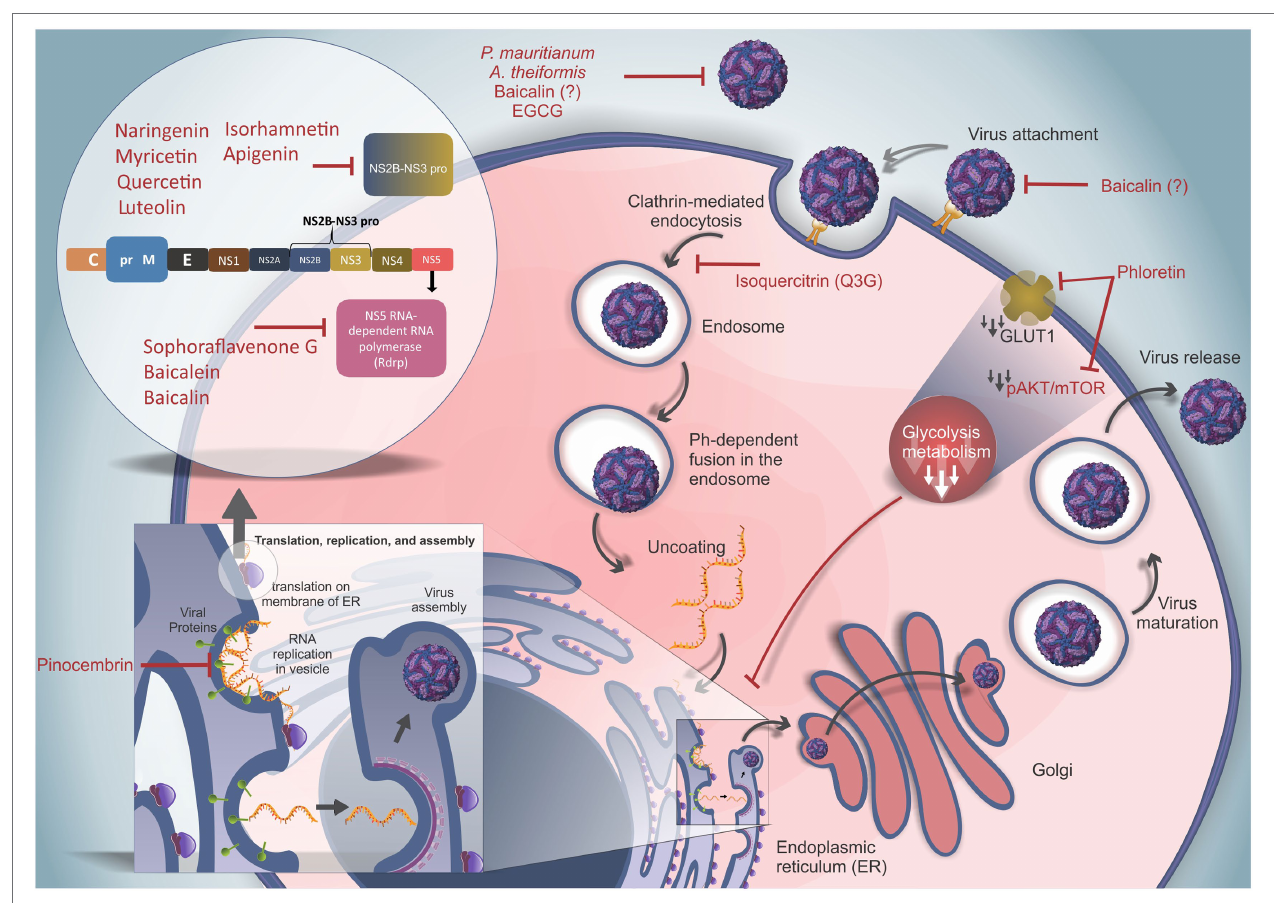
FIGURE 3 | Replication cycle of ZIKV and the actions of different flavonoids. Free viral particles can be disrupted by the actions of curcumin, Psiloxylon mauritianum extract, Aphloia theiformis extract, baicalin, and epigallocatechin gallate (EGCG) before binding of the virus to cell receptors. ZIKV attaches to host receptors and is internalized by clathrin-mediated endocytosis. This phase can be inhibited by curcumin and baicalin, but the inhibitory mechanism needs to be clarified. Isoquercitrin (Q3G) inhibits the internalization and trafficking of viral particles. The acidic microenvironment within endosomes allows the fusion between viral and endosomal membranes, resulting in viral RNA release into the cytoplasm. The viral RNA is translated into a polyprotein (inset in the upper left corner shows the sequential and structural organization of the ZIKV polyprotein) containing three structural proteins [capsid (C), premembrane (prM), and envelope (E)] and seven nonstructural proteins (NS1, NS2A, NS2B, NS3, NS4A, NS4B, and NS5). The viral polyprotein is cleaved by host and viral proteases. NAR, myricetin, quercetin, luteolin, isorhamnetin, apigenin, and curcumin can inhibit the NS2B-NS3 protease (NS2B-NS3 pro). Conversely, sophoraflavenone G, baicalein, and baicalin can inhibit NS5-RNA polymerase (RDRP). Moreover, the NS3 protein interacts with RDRP to allow viral genome replication, and pinocembrin can impair viral RNA synthesis. Phloretin was demonstrated to decrease glycolytic metabolism by downregulating the pAKT/mTOR pathway and GLUT1 blockade, impairing ZIKV replication by downmodulating energetic metabolism. (?) Highlights molecules with inconsistent